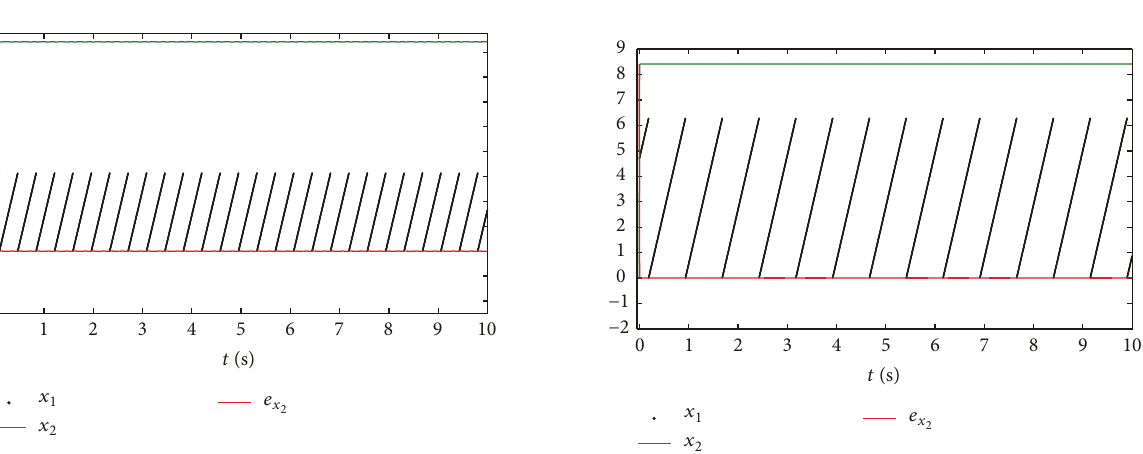
Figure 7: Double-cylinder with SDRE control by position and constant velocity ( 𝑥 2∗ = 8.415 rad/s =